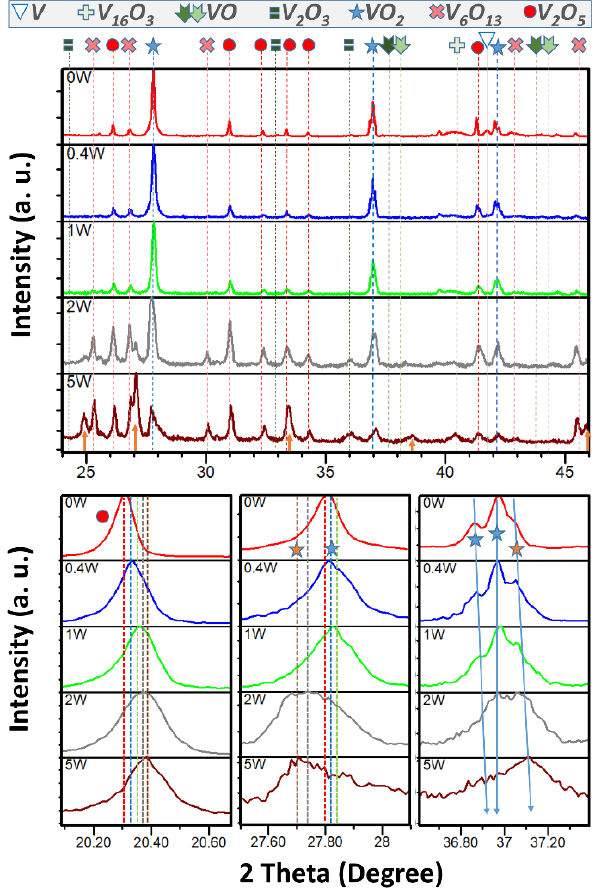
Figure 8. X-ray diffraction patterns for samples heat treated with the optimum 2-cycles method, together with some insets of amplifications. Note that arrows and stars in orange are in diffraction positions proper to the (V 0.8 W 0.2 ) 3 O 7 and R-VO 2 phases, respectively.